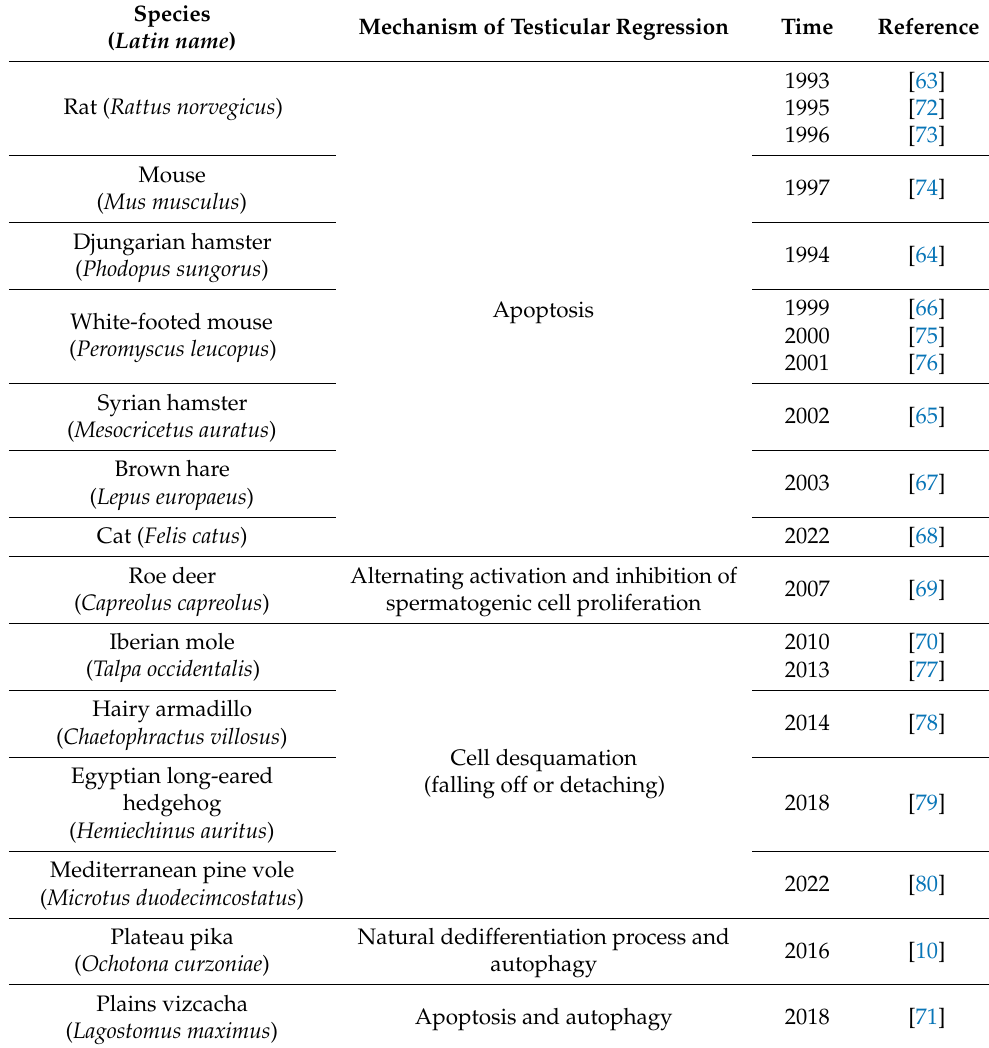
Table 1. Main research progress on the mechanism of testicular regression in